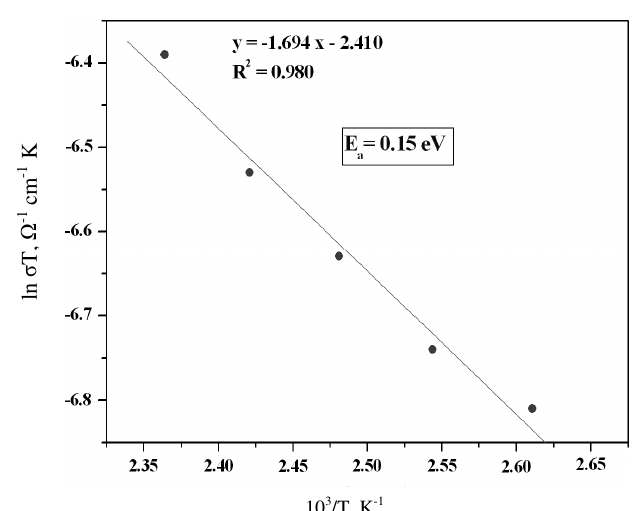
Figure 7. Temperature dependence of the conductivity of [C